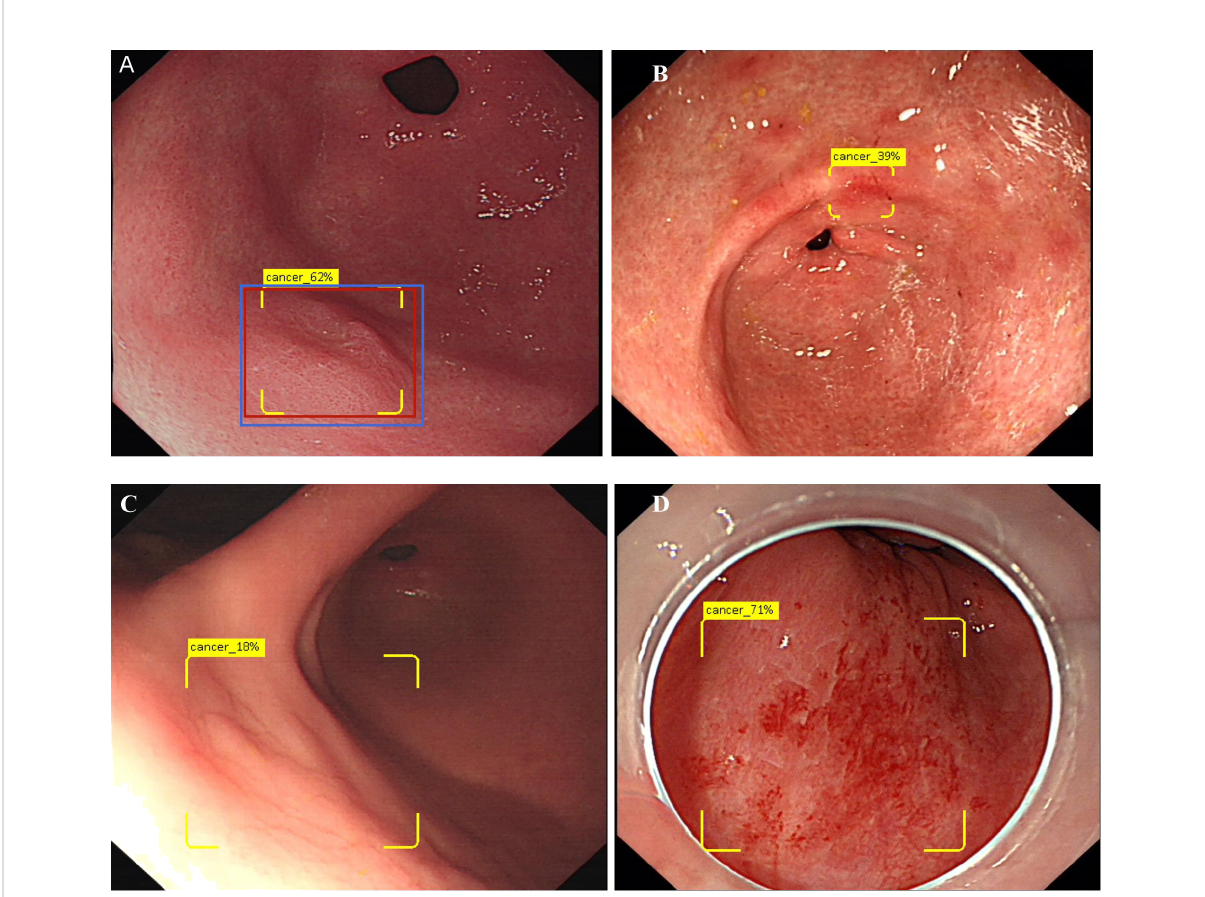
FIGURE 1 Show the concept of correctly identi fi es and diagram of DCNN producing false positives. (A) Show 0-IIa lesion in the anterior wall of gastric antrum, the red rectangle is the correct marking, the yellow box is the DCNN marking, and the blue rectangle is the endoscopist ’ s marking. Only when the overlap reaches 50% or more, the diagnosis is correct. The yellow logo shows “ Cancer 62% ” , indicating that DCNN predicts that the probability of EGC for this lesion is 62%. (B) Show an image offalsely diagnosing in fl ammation as EGC. (C) Show an image of DCNN diagnosed the normal mucosa in the re fl ective area as EGC. (D) Show an image of DCNN diagnosed the bleeding mucosa in the re fl ective area as